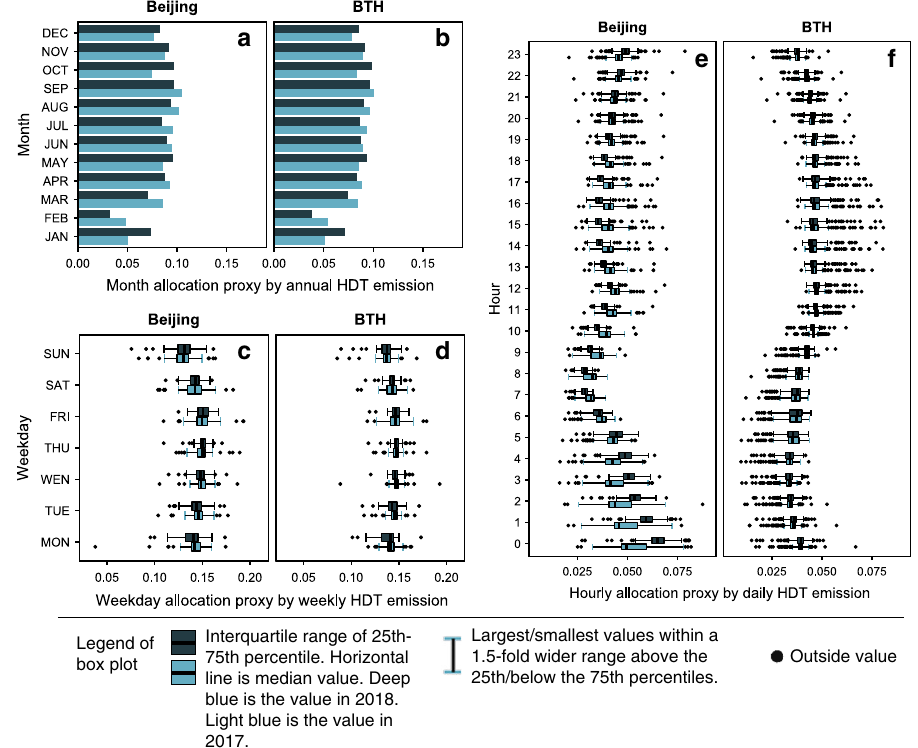
Fig. 4 The temporally allocated proxies at various time scales obtained by using the NO x emission data of HDTs. a Monthly allocation proxy in Beijing. b Monthly allocation proxy in the BTH region. c Weekday allocation proxy in Beijing. Where the n = 683 independent days. d Weekday allocation proxy in the BTH region. Where the n = 683 independent days. e Hourly allocation proxy in Beijing. Where the n = 16464 independent hours. f Hourly allocation proxy in the BTH region. Where the n = 16464 independent hours. Some samples during the special festivals were removed when statistics of weekday/ hourly proxies were conducted, to obtain more general results. *Source data are provided as a Source Data fi